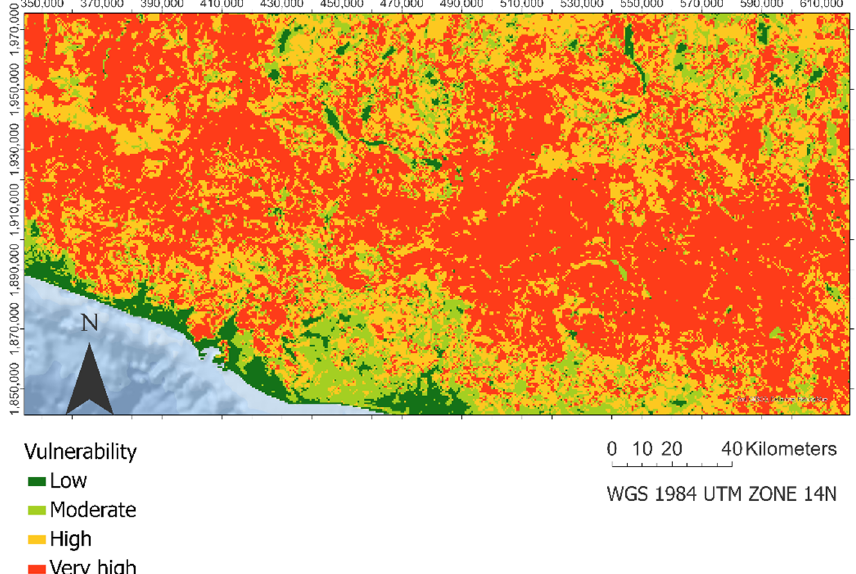
Figure 3. Landslide ecological vulnerability.